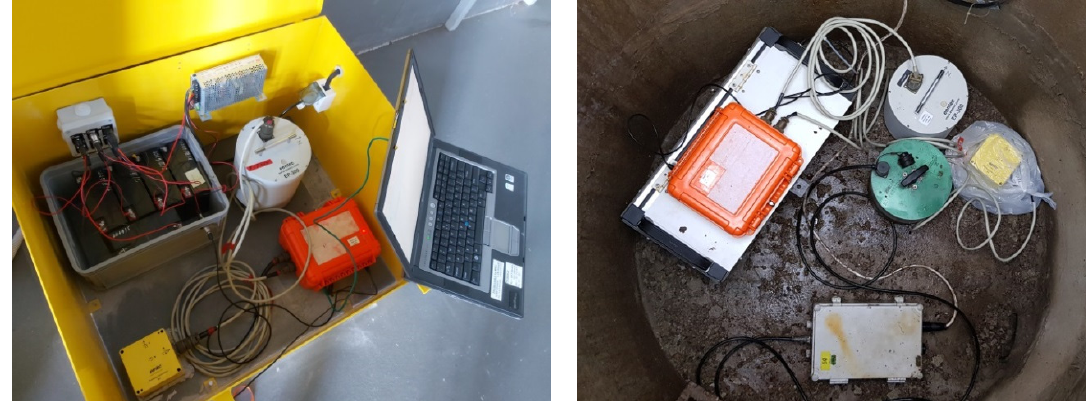
Figure 4. Systems for 6-DoF measurement installed near the Rudna-I shaft ( left ) and at the Zelazny Most tailing pond ( right ).